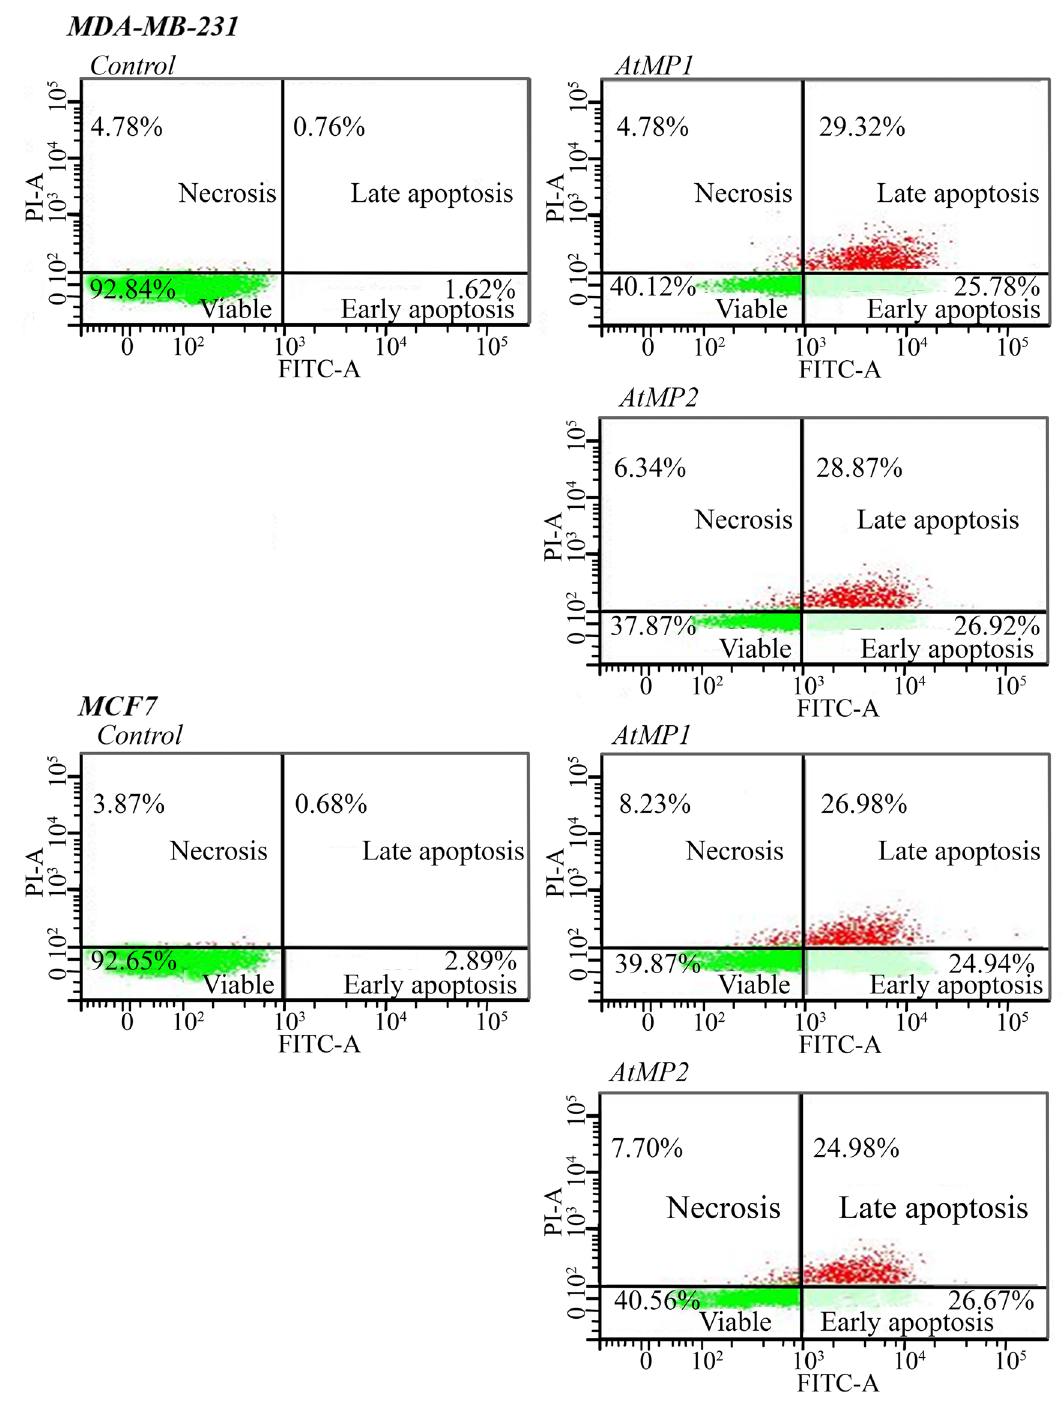
Figure 10. Apoptosis detection results by Anexien V FTIC-A